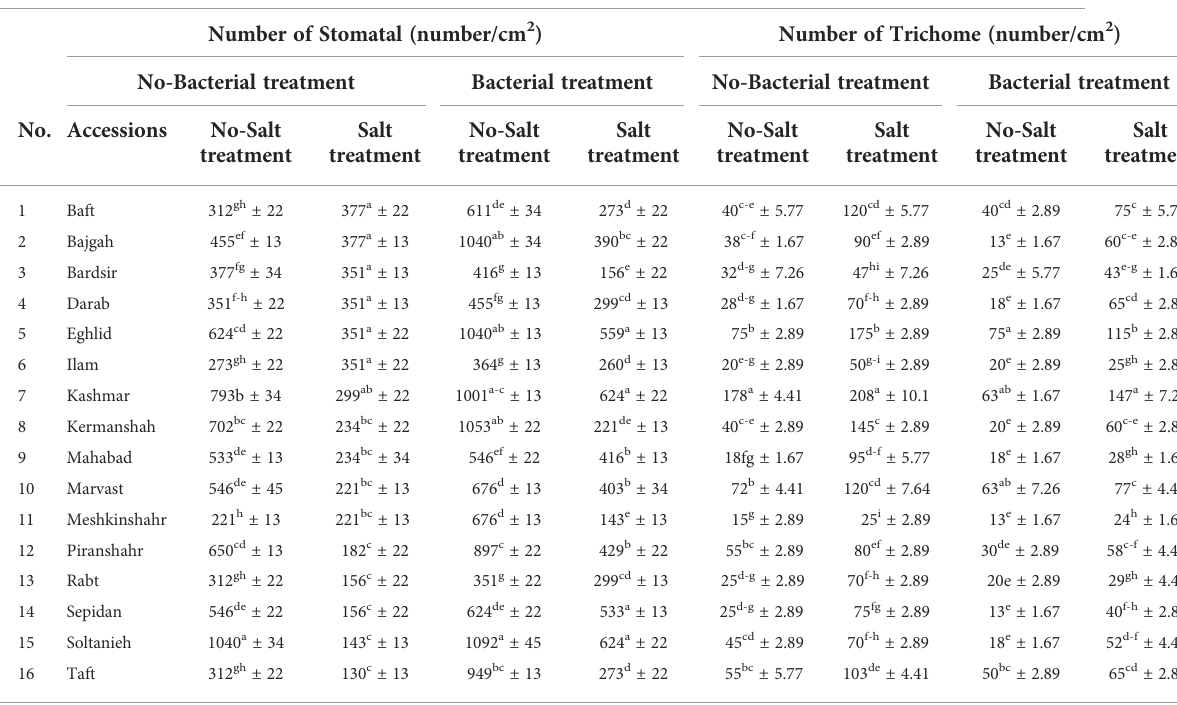
TABLE 4 Effect of Azotobacter and salinity stress interactions on number of stomatal and trichome of 16 Iranian licorice